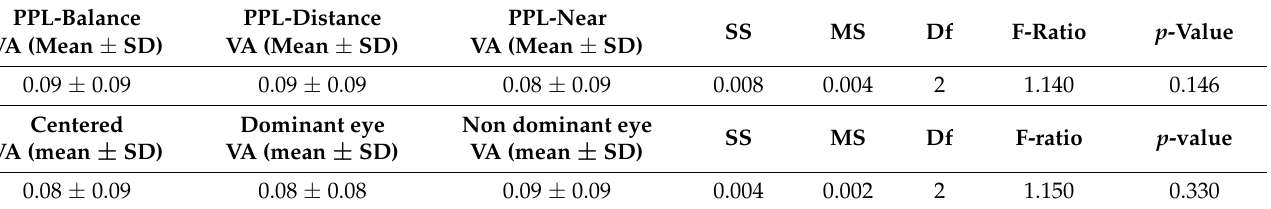
Table 3. Detailed statistics for VA analysis at near vision. Two-way repeated measures ANOVA.